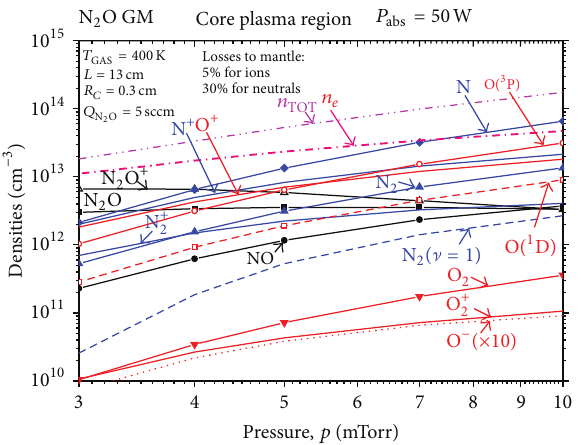
Figure 2: “Core” region densities of species of a N 2 O fed HPT of 50 W absorbed power. Pressure varies from 3mTorr to 10mTorr.